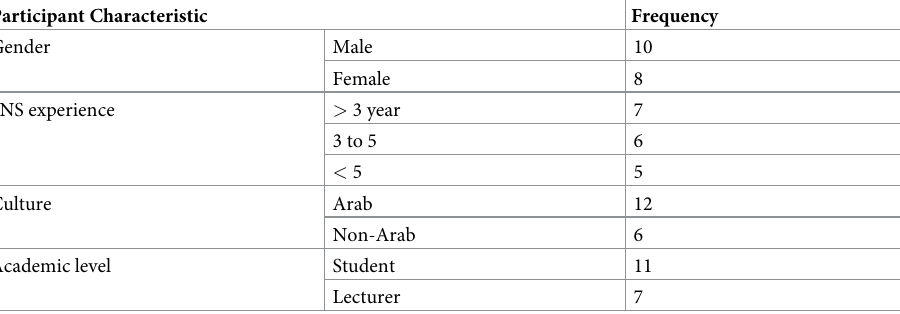
Table 1. Participants’ characteristic